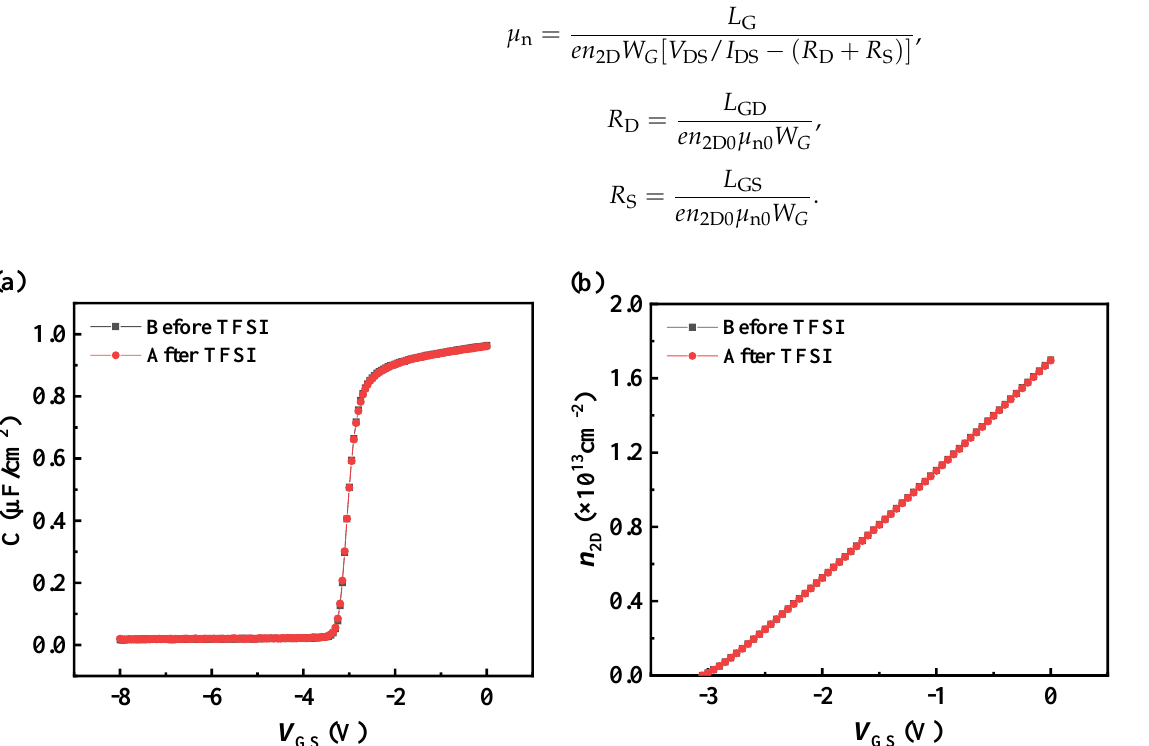
Figure 5. ( a ) Measured gate capacitance of InAlN/GaN HEMT before and after TFSI treatment; ( b ) Two-dimensional electron gas electron density ( n 2D ) of InAlN/GaN HEMT before and after TFSI treatment.